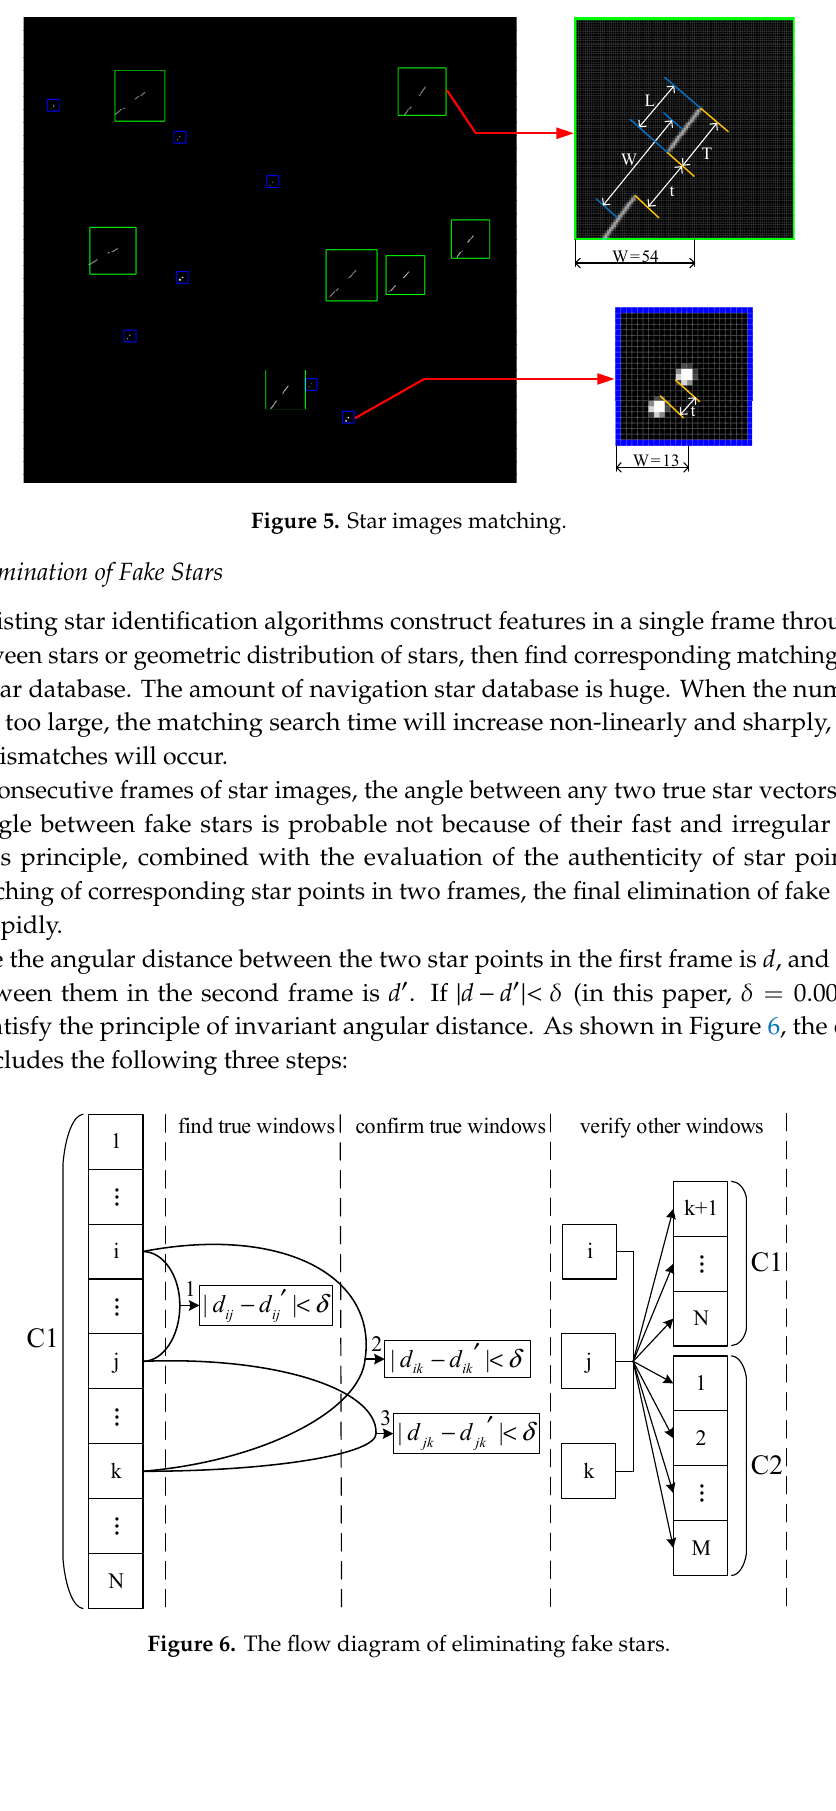
Figure 4. Calculating principle of matching window.